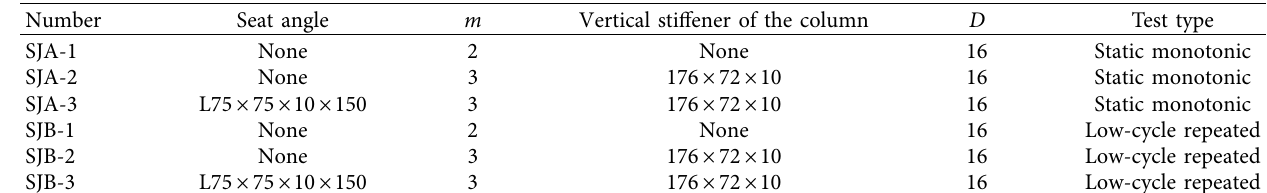
Table 1: Specimen information (mm).